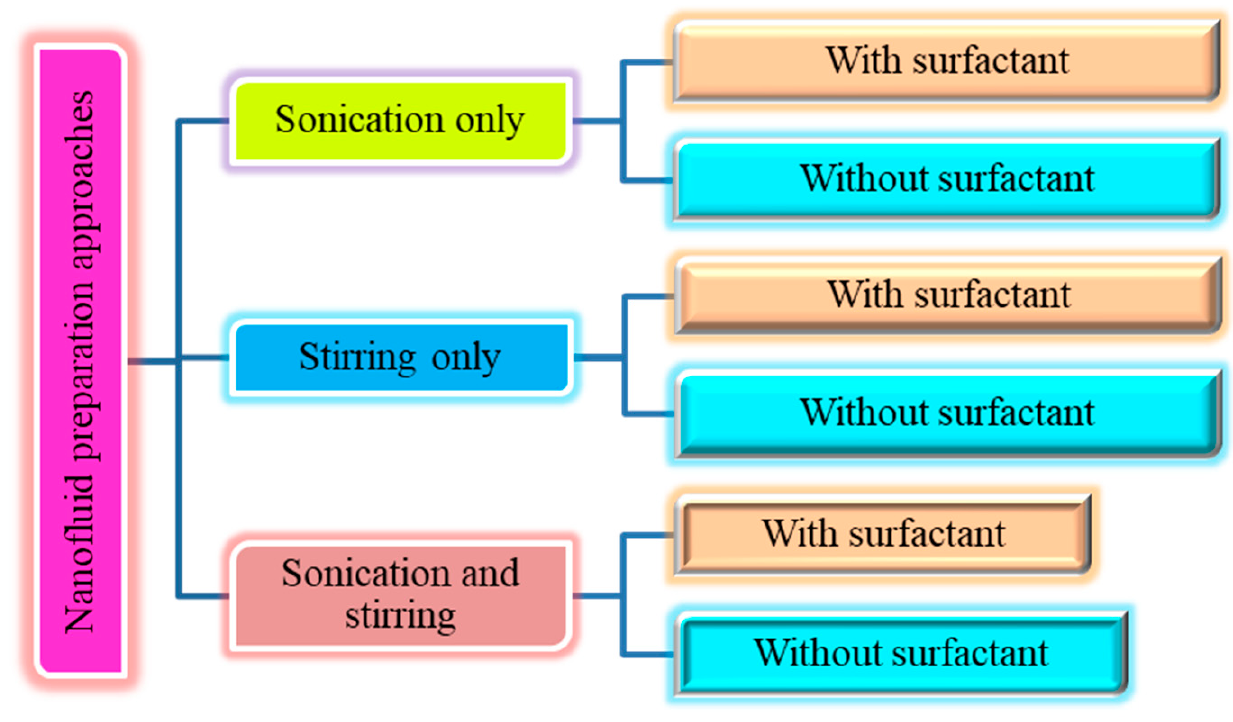
Figure 11. Nanofluid preparation approaches in the literature.